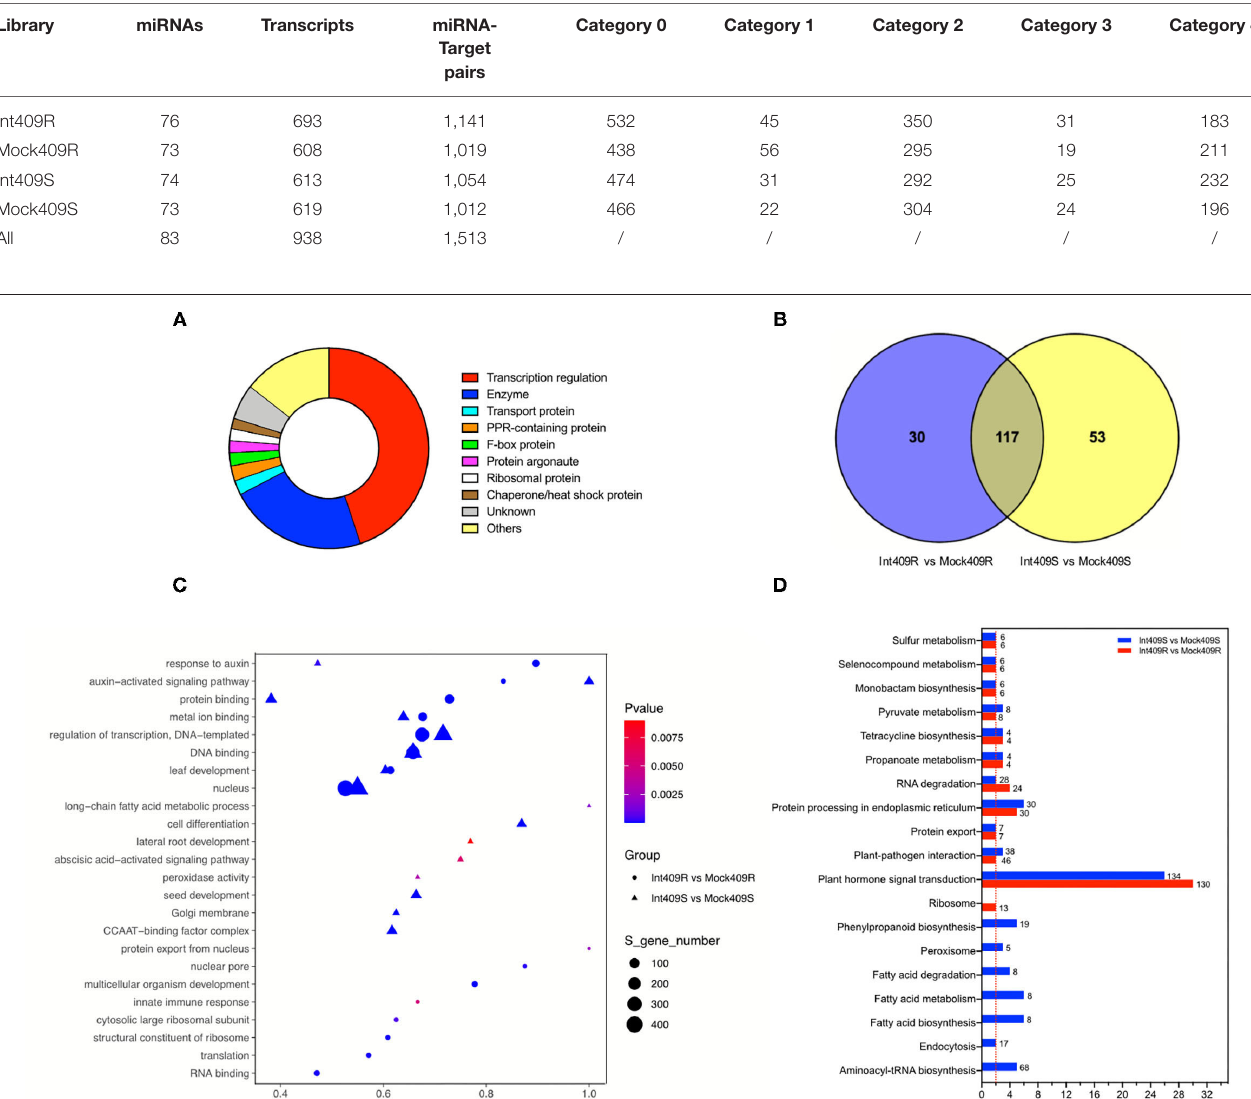
TABLE 4 | Numbers of target transcripts and miRNA-target pairs identified through sequencing.